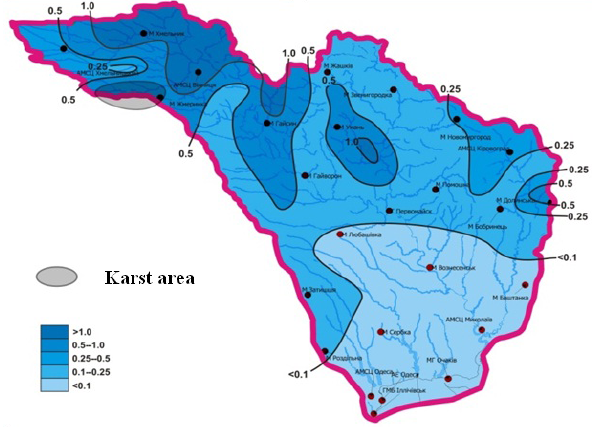
Figure 8. Distribution of 30d minimal runoff modulus with 80% probability during the winter period with stable freezing in the basins of the Southern Bug River L(skm 2 ) − 1 .